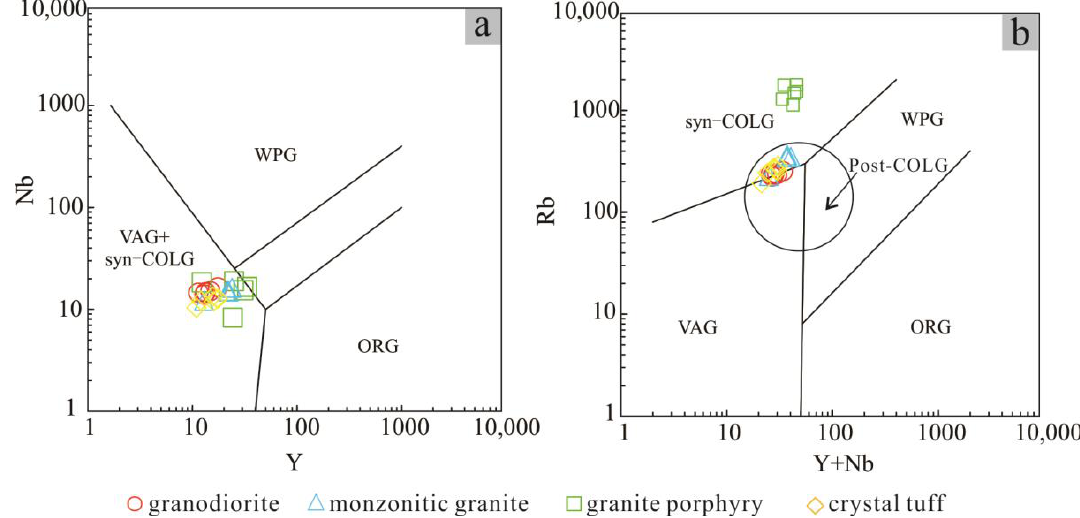
Figure 14. ( a ) Nb–Y diagram; ( b ) Rb–(Y + Nb) diagram for the granitic rocks and crystal tuff of the Hutouya deposit ([58], WPG, within-plate granites; VAG, volcanic arc granites; Syn-COLG, syn-collision granites; Post-COLG, post-collision granites; ORG, ocean ridge granites).